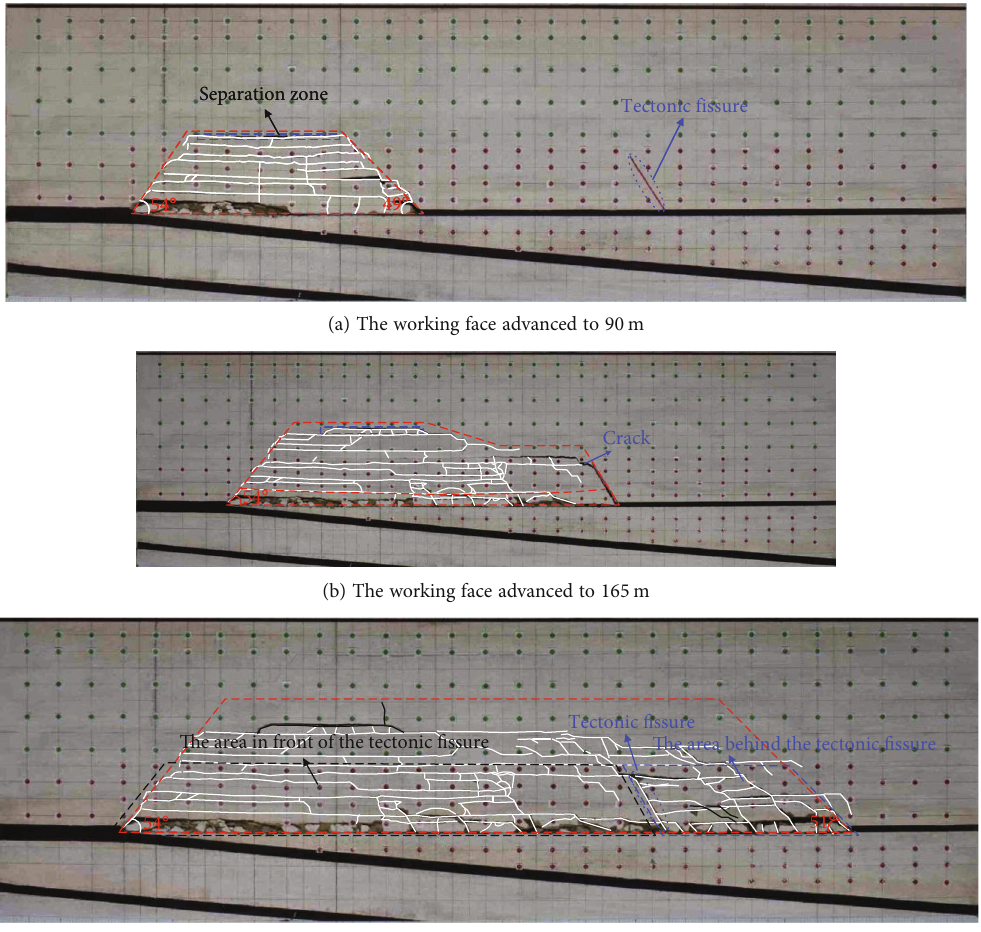
Figure 5: Deformation characteristics of overburden during no. 7-1 coal seam